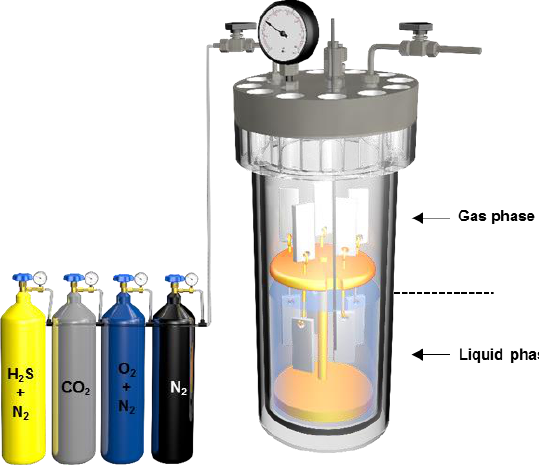
Figure 2. Schematic diagram of the setup for simulating the environment of flue gas injection in laboratory. Table 2. Test conditions of corrosion of G20 steel in simulating flue gas injection environment.